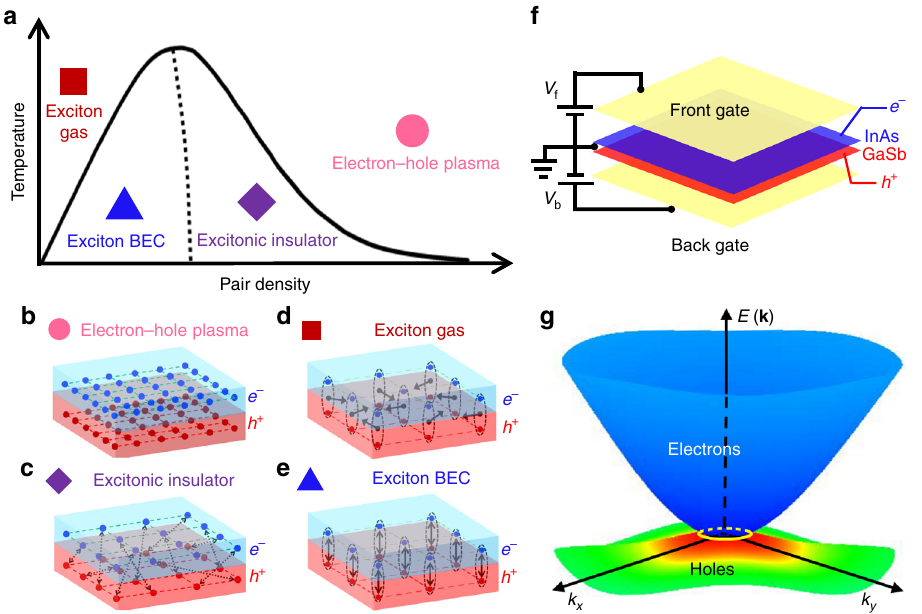
Fig. 1 Excitonic insulator in inverted InAs/GaSb quantum wells tuned by double gates. a Phase diagram for an electron – hole (e – h) system in the parameter space of temperature and e – h pair density. b Pink circle: an e – h plasma (or a semimetal). c Purple diamond: the excitonic insulator, where electrons and holes are weakly bound, like Cooper pairs. d Red square: an exciton gas consisting of bosonic particles with a fi nite center-of-mass momentum. e Blue triangle: exciton Bose – Einstein condensate, where the exciton states are degenerate. In b – e , the blue dots represent electrons, the red points are holes, the dashed ellipses indicate the strong binding between electrons and holes, the dashed lines with arrows mean the weak binding between electrons and holes, and the single arrows show the center-of-mass movement of excitons. f Sketch of a device with front and back gates. The back-gate is used to fi x p 0 , and sweeping the front-gate voltage allows us to fi nd a resistance peak at the charge-neutral-point, n 0 ~ p 0 . g Band structure of InAs/GaSb quantum wells calculated using the 8-band k · p method, for low n